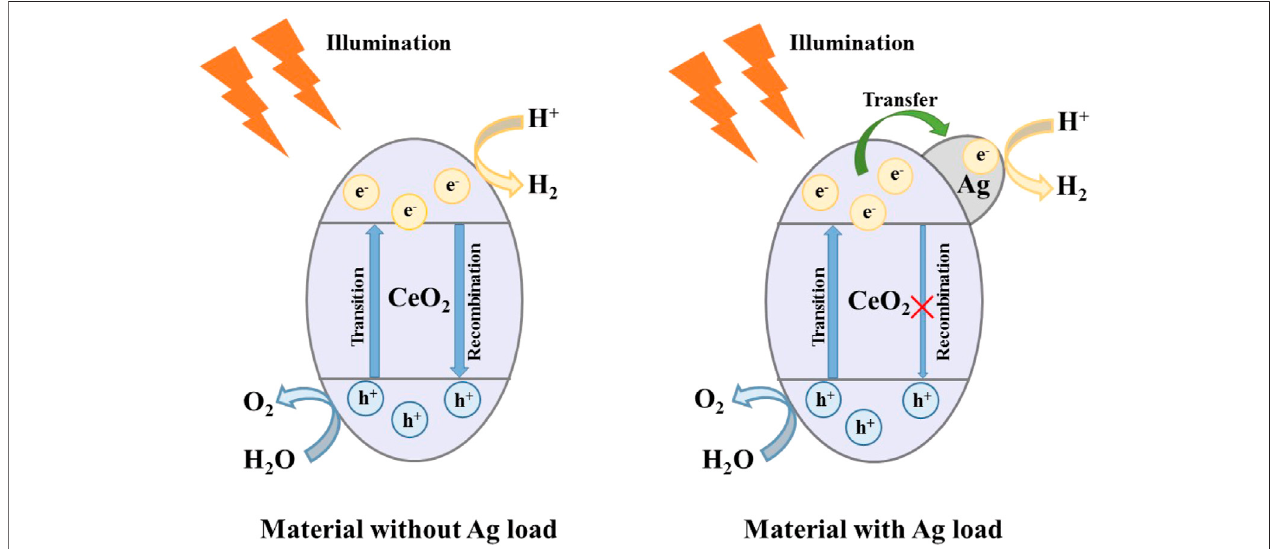
FIGURE 9 | Photocatalytic mechanism of CeO 2 and Ag/CeO 2